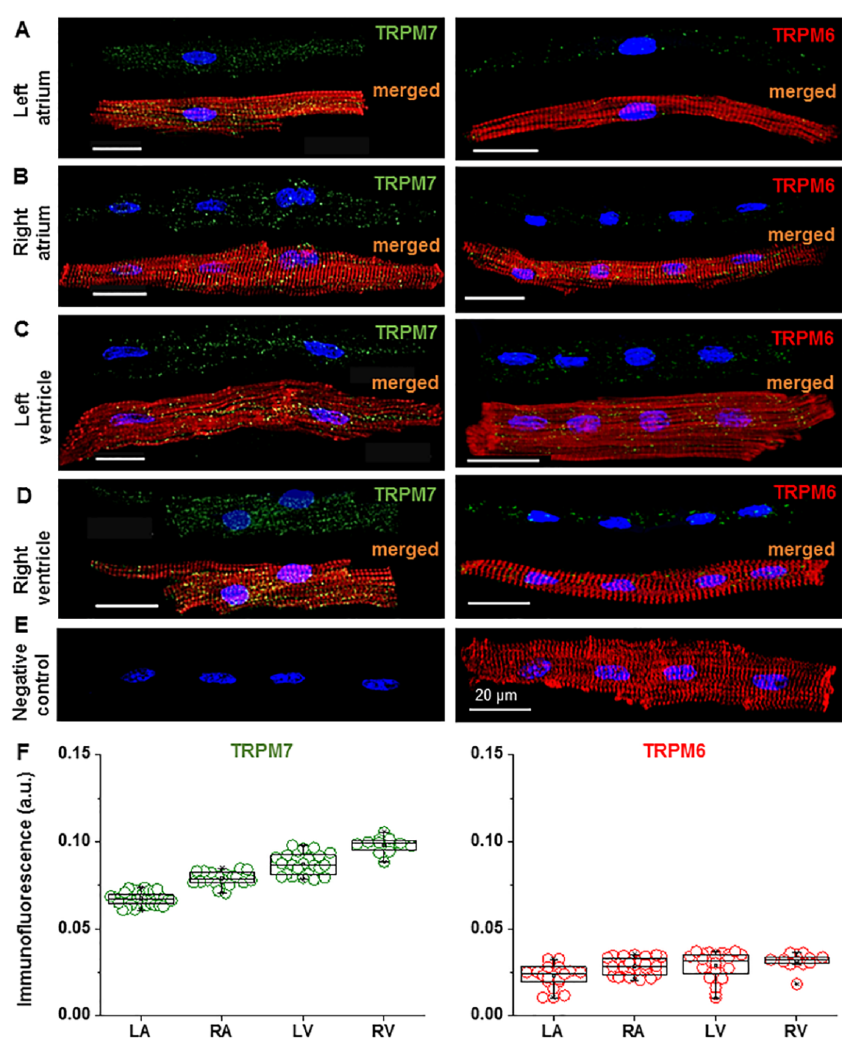
Figure 1. Immunofluorescence images suggesting the presence of TRPM6 and TRPM7 proteins in pig cardiomyocytes from different cardiac chamber walls. ( A – D ) Immunofluorescence of TRPM7 (left) and TRPM6 (right) in the left atrium (LA), right atrium (RA), left ventricle (LV), and right ventricle (RV) cardiomyocytes when using Alexa Fluor 488 for the TRPM7 and TRPM6 proteins (stained in green), Alexa Fluor 546 for the F-actin cytoskeleton (stained in red), and Hoechst 33342 for the nuclei (stained in blue). Scale bars indicate 20 µm. ( E ) Example of a negative control, where the primary antibody for TRPM6 and/or TRPM7 is not added, but the cardiomyocyte was subjected to Hoechst 33342 and Alexa Fluor 546. Under such conditions, only immunofluorescence of the nu- clei (stained in blue) and F actin cytoskeleton (stained in red) is detected. Note: same cardiomyocyte in the left and right (merged image) panels ( F ) Quantification of the staining intensity of the immu- nodetected fluorescence of TRPM7 and TRPM6 in the four cardiac chamber walls: LA, RA, LV, and RV. The mean data is provided in arbitrary units (a.u.) (see Table 1). A blinded study design (with the origin or treatment of cells unknown to the investigator) was used for the detection of immuno- fluorescence during the various experimental conditions.